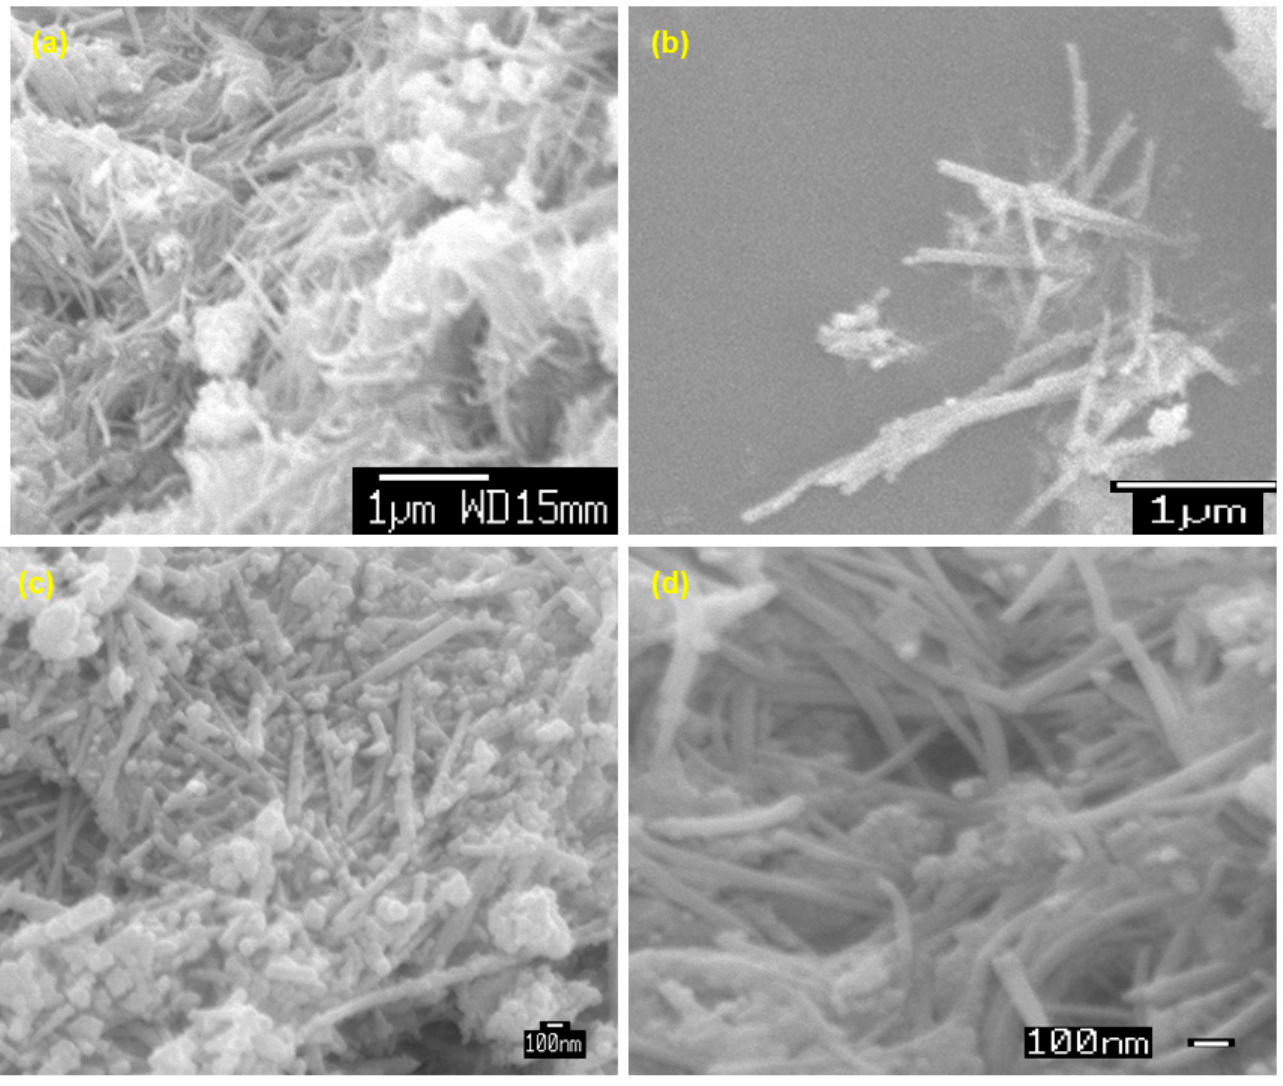
Figure 4. SEM images of CSLDH-2 at different locations.